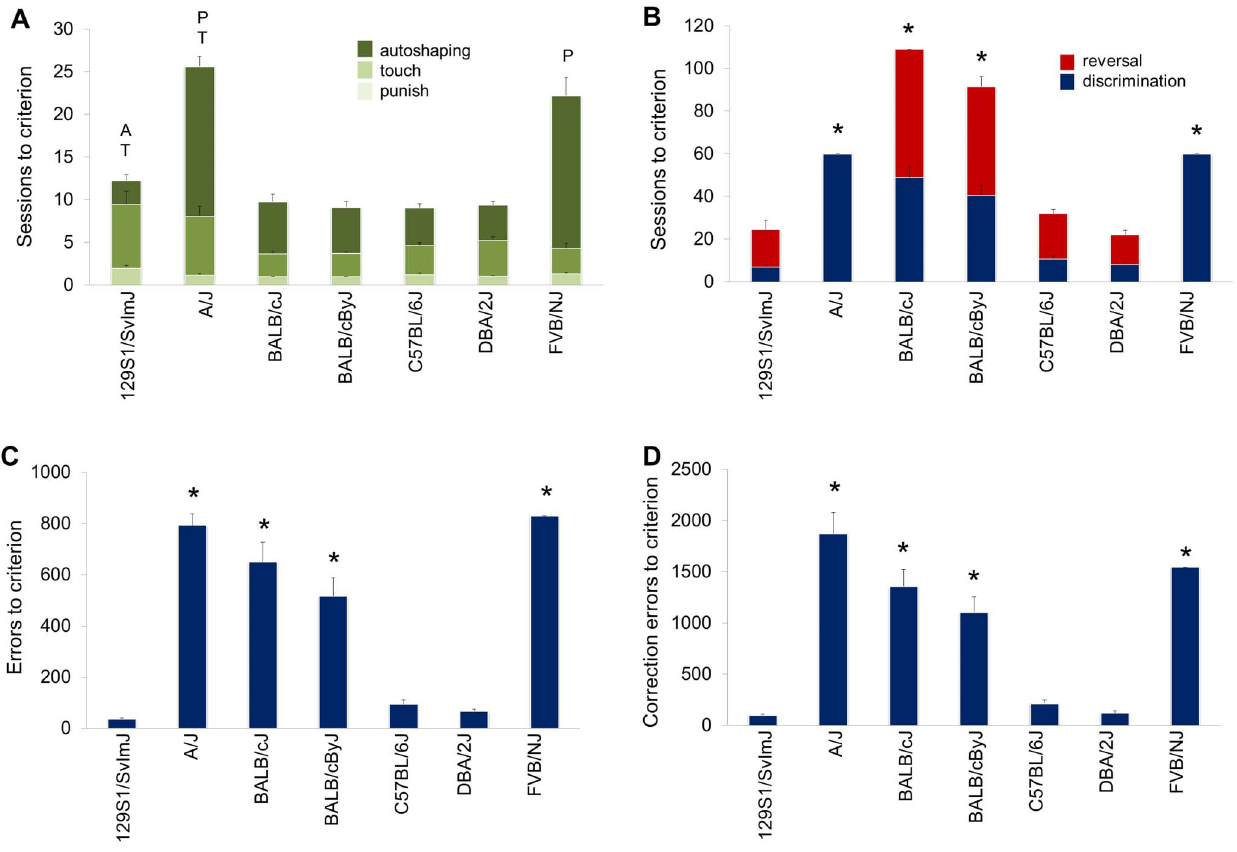
Figure 1. Inbred strain differences in pre-training performance, and in discrimination and reversal learning. ( A ) Sessions to autoshaping, touch and punish criterion. ( B ) Sessions to discrimination and reversal criterion. Errors ( C ) and correction errors ( D ) to discrimination criterion. A P , .05 autoshaping session relative to C57BL/6J, T P , .05 touch sessions relative to C57BL/6J, p P , .05 punish session relative to C57BL/6J, * P , .05 discrimination, reversal, errors or correction errors relative to C57BL/6J. n=9–27 per strain. Data are Means 6